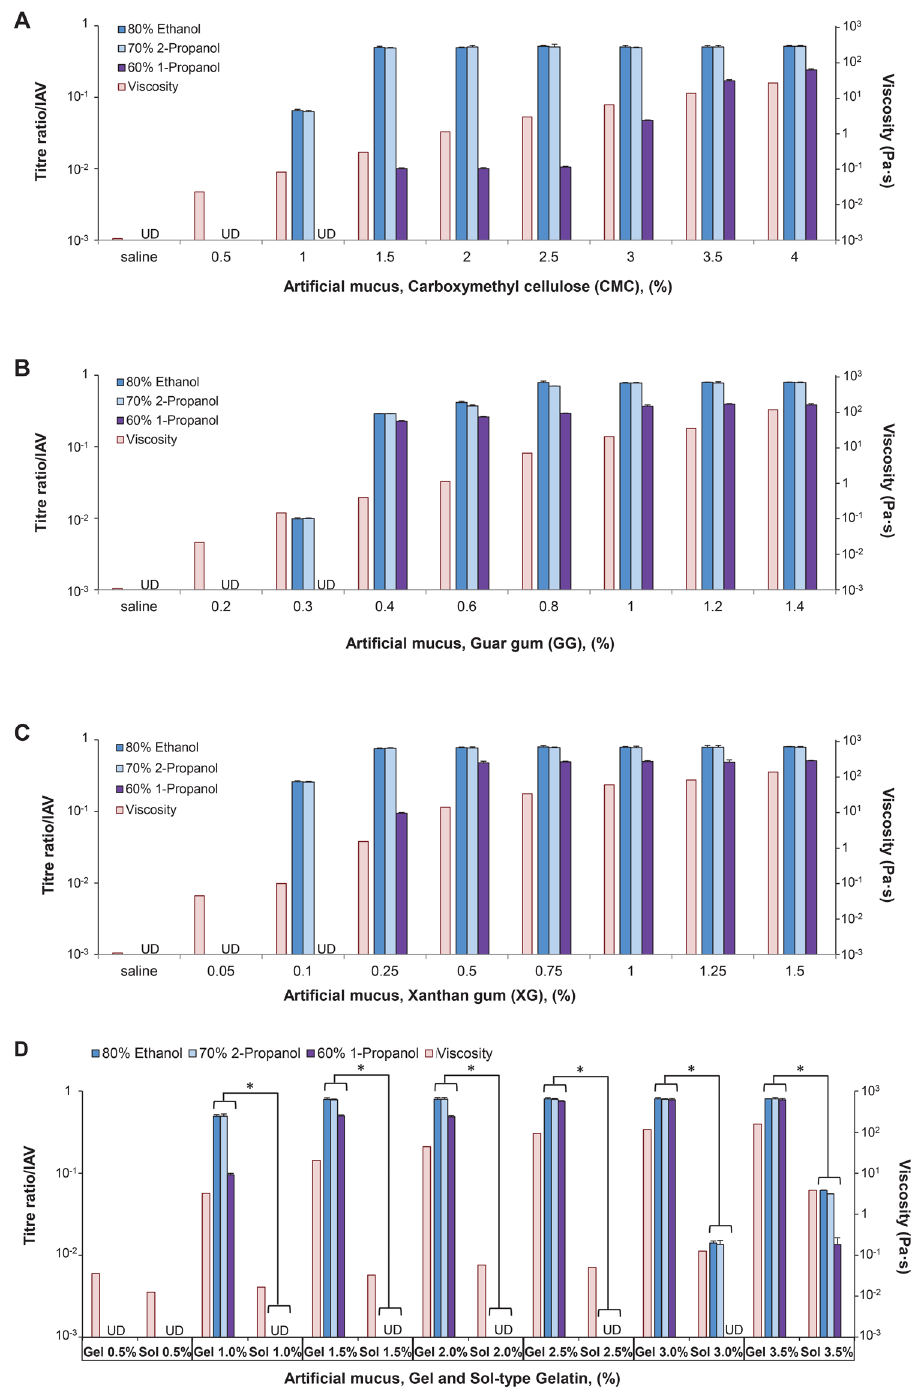
Figure 1. Artificial mucus protects influenza A virus (IAV) against alcoholic disinfectants. IAV [PR8, A/Puerto Rico/8/1934 (H1N1)] was mixed with artificial mucus and incubated for 30 s with alcohol-based disinfectants (80% ethanol, 70% 2-propanol, or 60% 1-propanol) before titre ratio was measured. A rheological analysis was also carried out to evaluate viscosity of artificial mucus. Viscosity of artificial mucus and titre ratios when IAV was mixed with carboxymethyl cellulose-based ( A ), guar gum-based ( B ), xanthan gum-based ( C ), and gelatin- based ( D ) artificial mucus followed by incubation with alcohol-based disinfectants. Titre ratio was defined as the ratio of the titre measured after incubation with disinfectant to the titre measured after incubation with PBS alone. The titre ratio reflected the proportion of virus (IAV) that was not inactivated by the disinfectant. Data are expressed as mean ± S.D. of at least three independent experiments. UD, undetectable. * P <